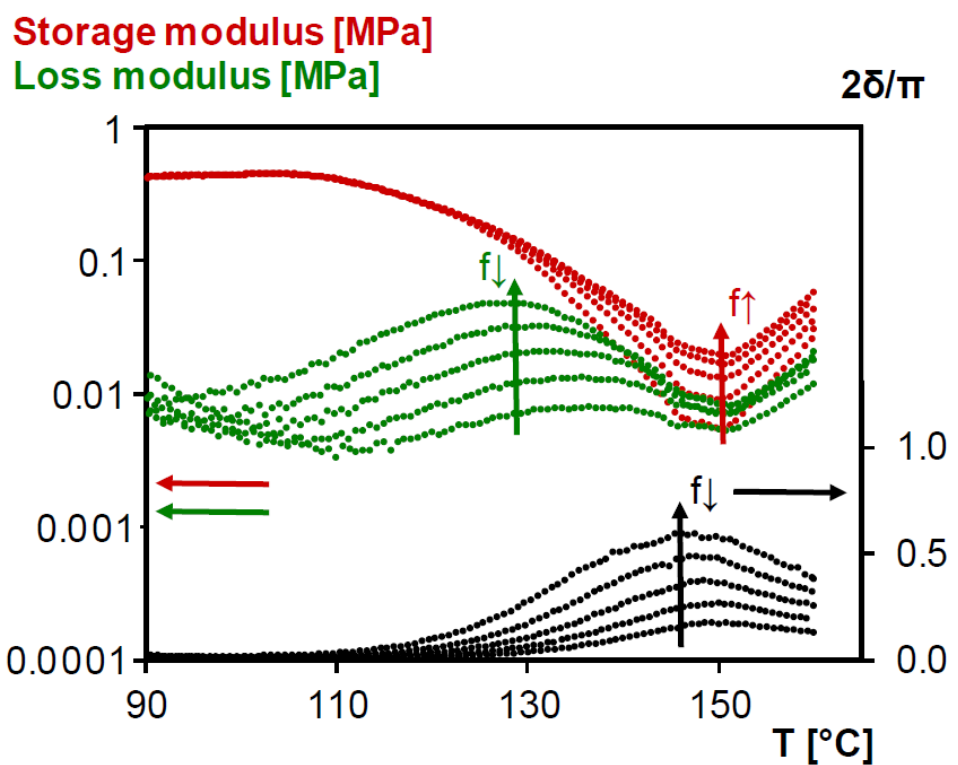
Figure 8. Storage modulus, loss modulus and normalized loss angle of dynamic rheometry during heating at 0.5 K min − 1 between 90 and 160 ◦ C of previously cured reversible network 3M-3F630. Black : normalized loss angle; Red : storage modulus; Green : loss